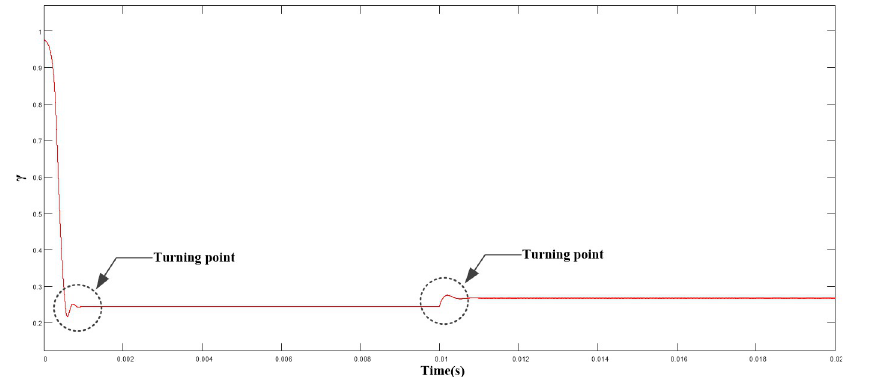
Fig 12. Variation curve of γ under load